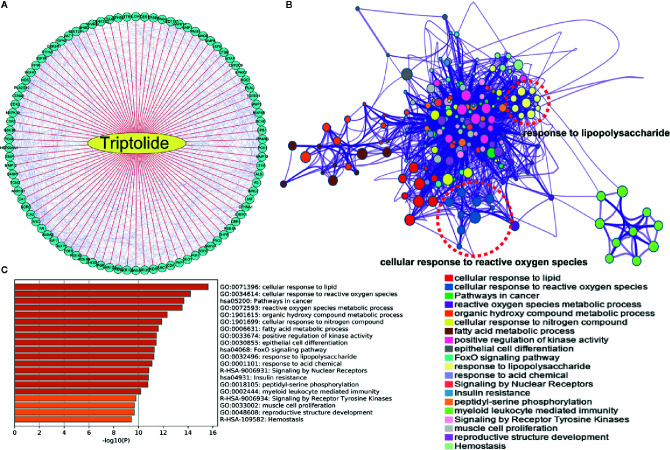
The underlying target of triptolide by network pharmacology analysis. (A) The potential targets of triptolide were analyzed by the PharmMapper website. The (B) PPI network and (C) heatmap showed the regulated top 10 KEGG and GO signaling pathways of triptolide by the Metascape website.